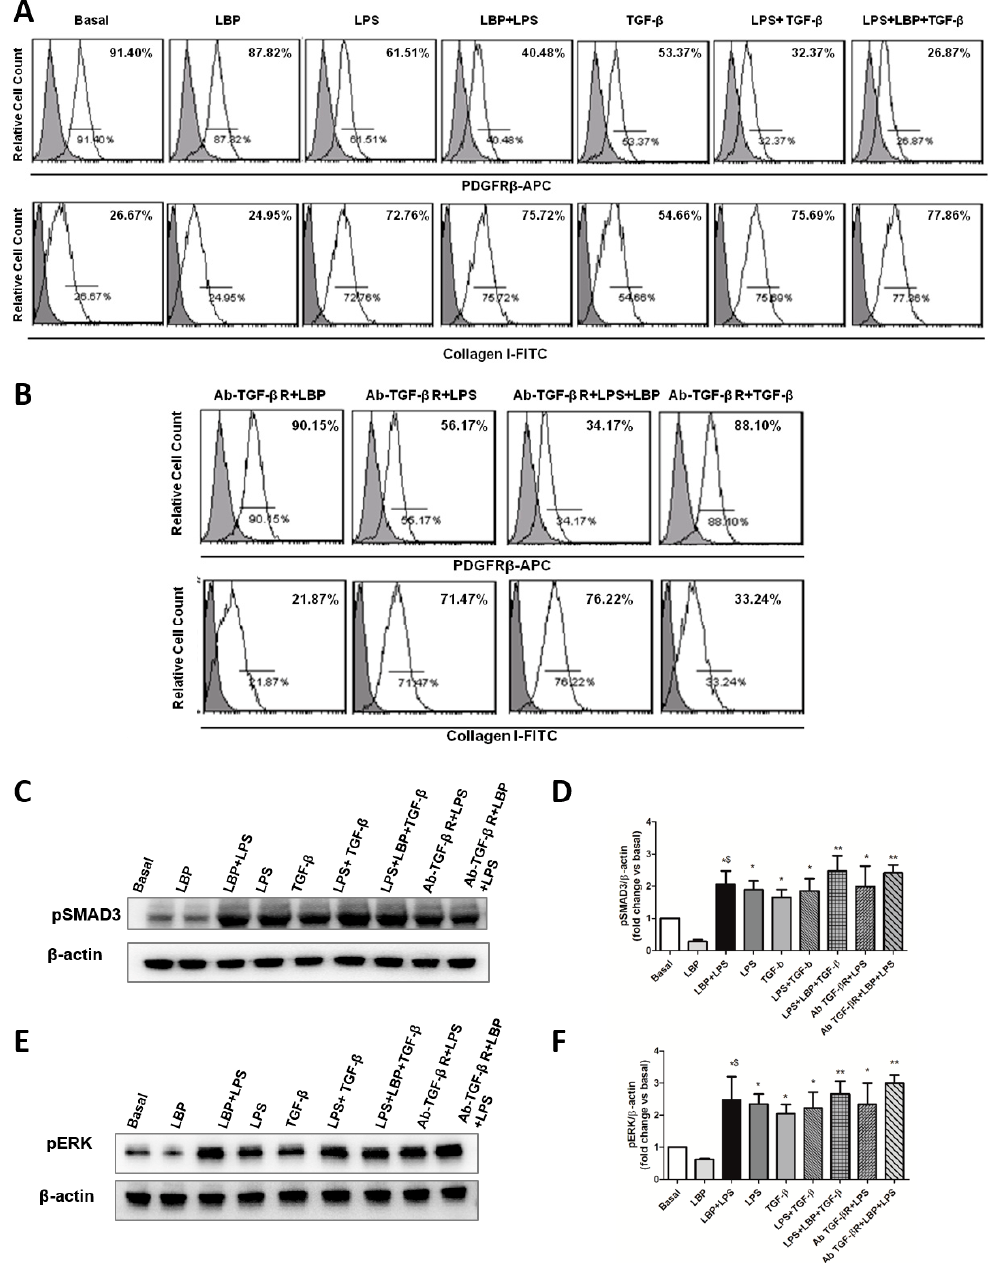
Figure 6. LBP-LPS axis induced PMT upon blocking TGF- β R. ( A ) Cultured pericytes were treated with LBP and/or LPS or TGF- β and with LBP, LPS, and TGF- β mixture for 24 h. LBP alone did not induce phenotypical changes in pericytes. Pericytes treated with LBP and LPS in combination or with LBP, LPS, and TGF- β mixture additively increased Collagen I expression and decreased PDGFR β marker.( B ) Pericytes were pretreated with anti-TGF- Β r-specific neutralizing antibody for 1 h followed by LPS and/or LBP stimulation for 24 h. FACS analysis showed that pericytes acquired phenotypic change also upon TGF- β R-blocking. Results are representative of three independent experiments. ( C – F ) Pericytes were pretreated with anti-TGF- β R specific neutralizing antibody for 1 h followed by LPS and/or LBP for short stimulation time (30 min). Pretreatment of pericytes with anti-TGF- β R antibody did not reduce LPS and LPS / LBP-induced phosphorylation of both SMAD3 ( C , D ) and ERK1 / 2 ( E , F ) at 30 min. Results are representative of three independent experiments. Data are shown as mean ± standard deviation (SD) and compared with the Student t test ( D , F : * p < 0.05, ** p ≤ 0.005, versus basal level; $ p < 0.05 versus